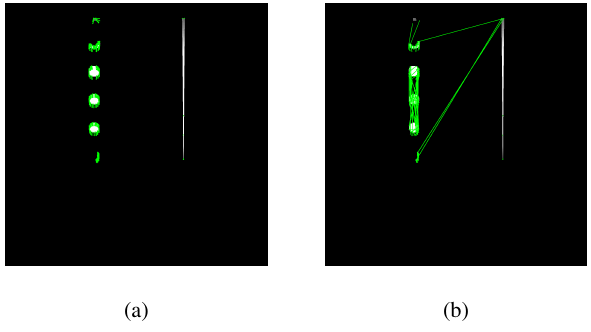
Figure 10: 3D scene used to generate the orthoimage in order to compare tracking and matching approaches